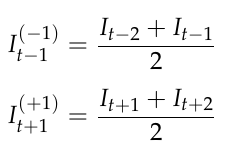
output by t from each t